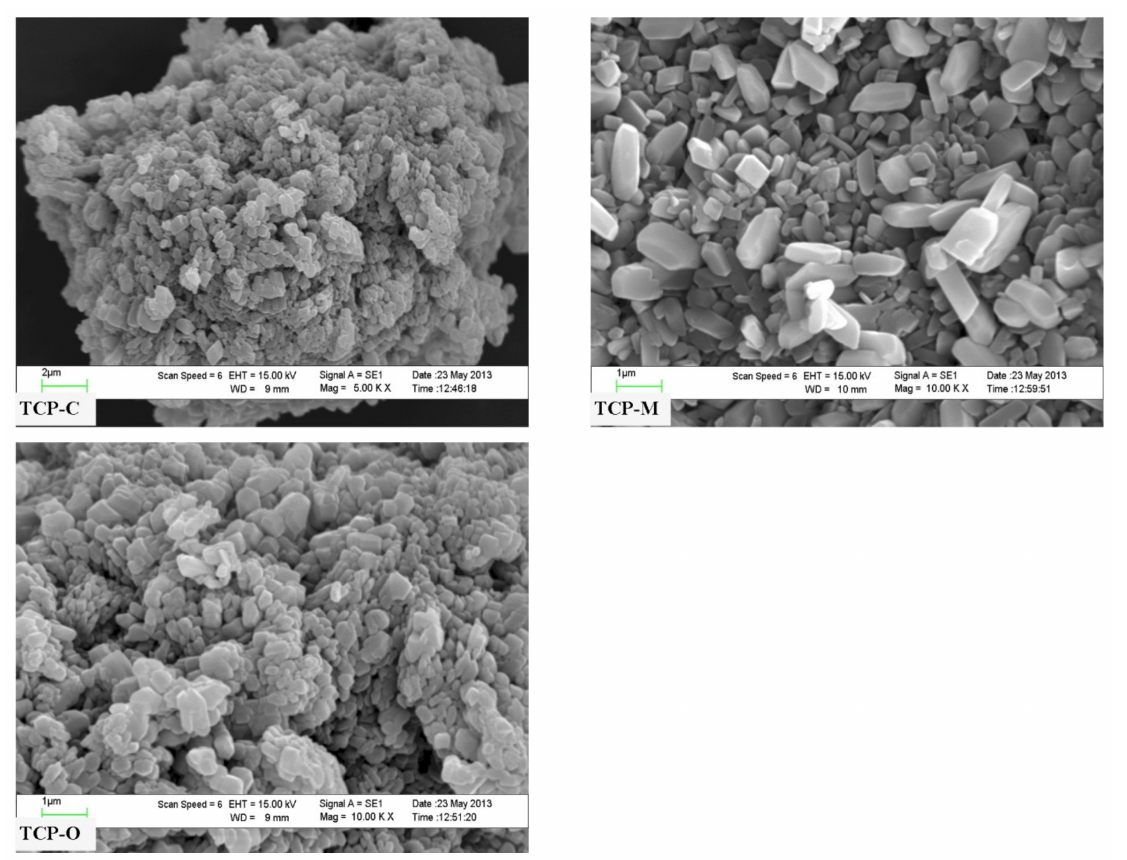
Figure 12. SEM micrographs of TCP-C, TCP-M and TCP-O